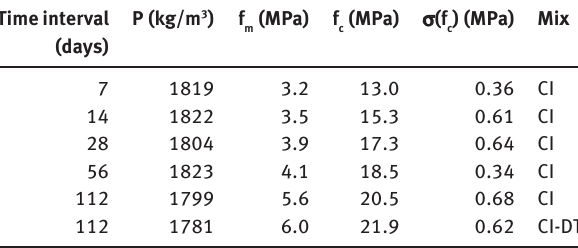
Table 6 Densities and mechanical properties of hardened fine grained concrete (mix CI and